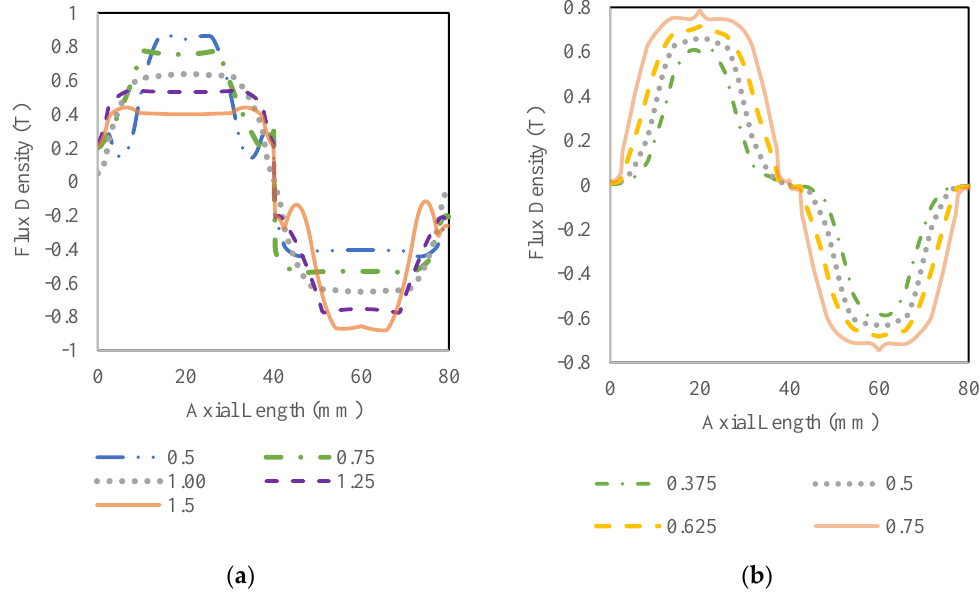
Figure 17. Pitch Ratio, τ m / τ p Influence on Airgap Flux Density of ( a ) TPMLM-NS; ( b ) TPMLM-S. For TPMLM-S, the airgap flux density trend with variation of 𝜏 𝑚 𝜏 𝑝 ⁄ is as shown in Figure 17b.